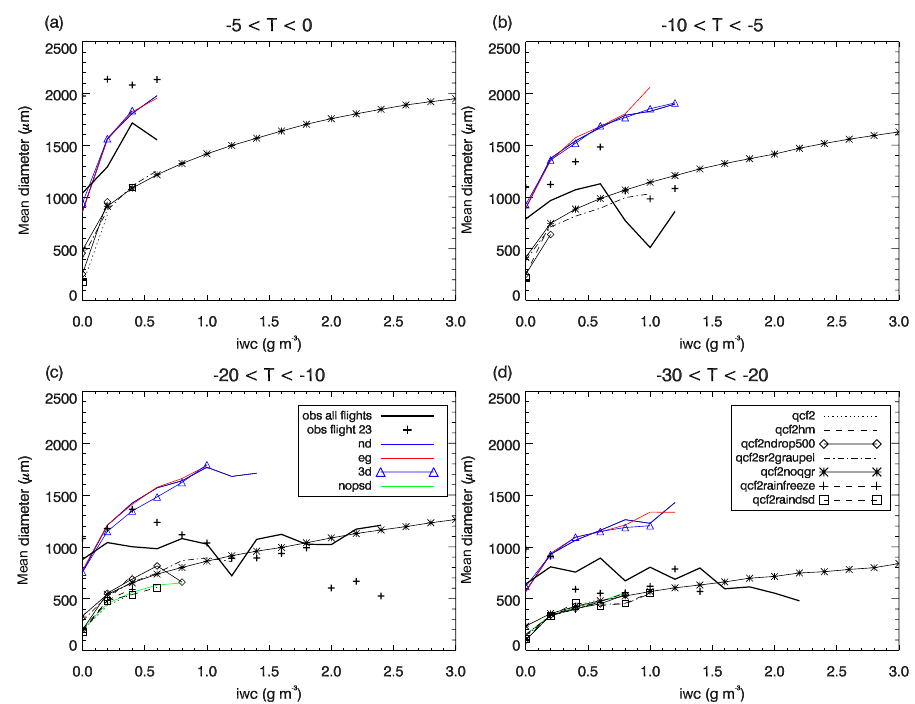
Figure 14. Mean mass-weighted ice particle size (µm) as a function of ice water content (gm − 3 ) for four temperature regimes: (a) − 5 to 0, (b) − 10 to − 5, (c) − 20 to − 1 and (d) − 30 to − 20 ◦